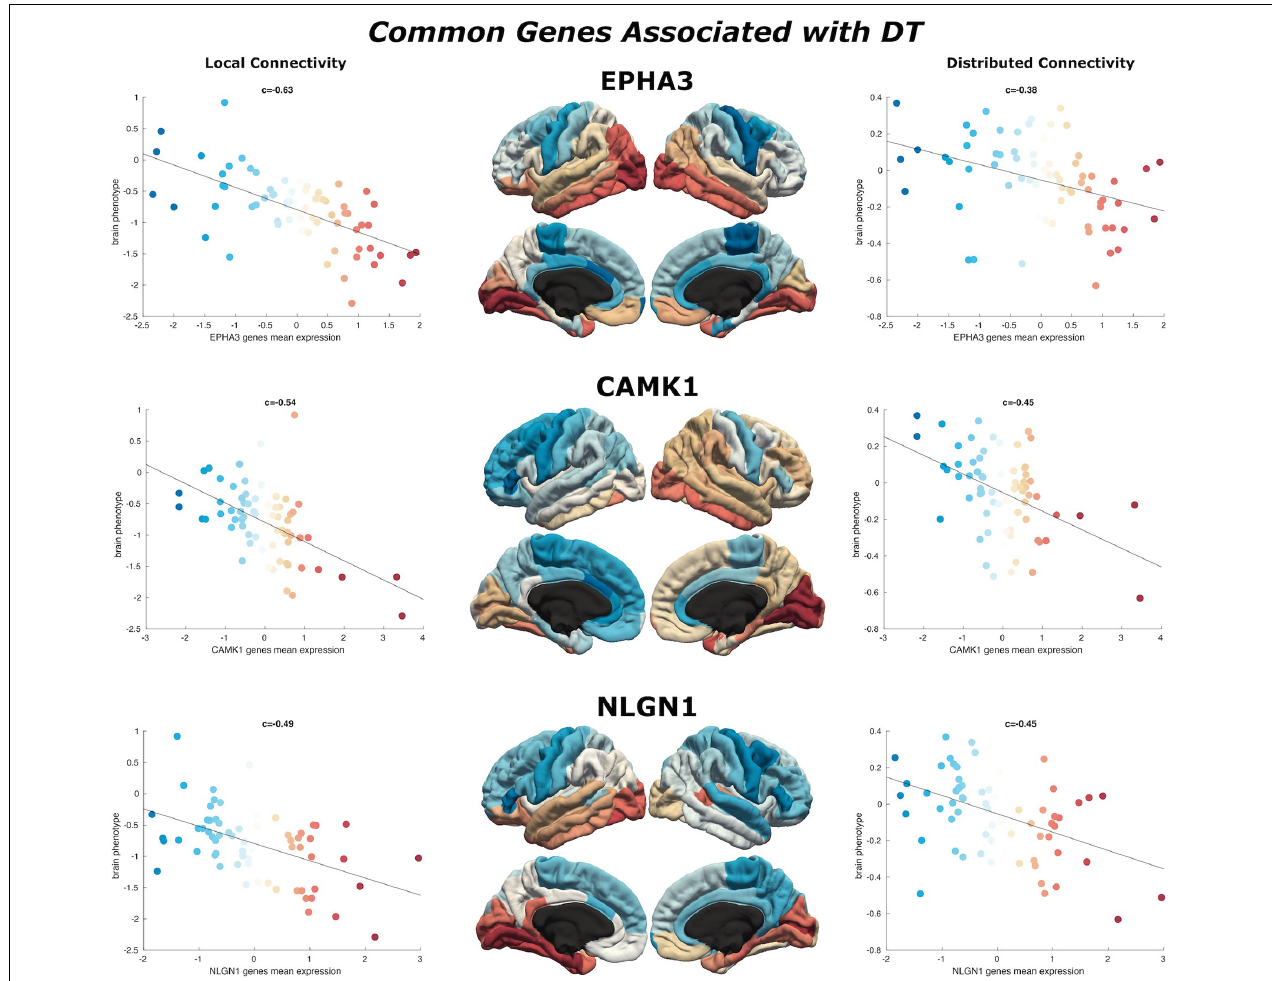
FIGURE 4 | Common genes associated with DT. Scatterplots show the spatial similarity relationship throughout brain regions between independent expression of three genes (EPHA3, CAMK1, and NLGN1), the local connectivity map ( left ) and the distributed connectivity map ( right ). Linear fit represented with a black line.